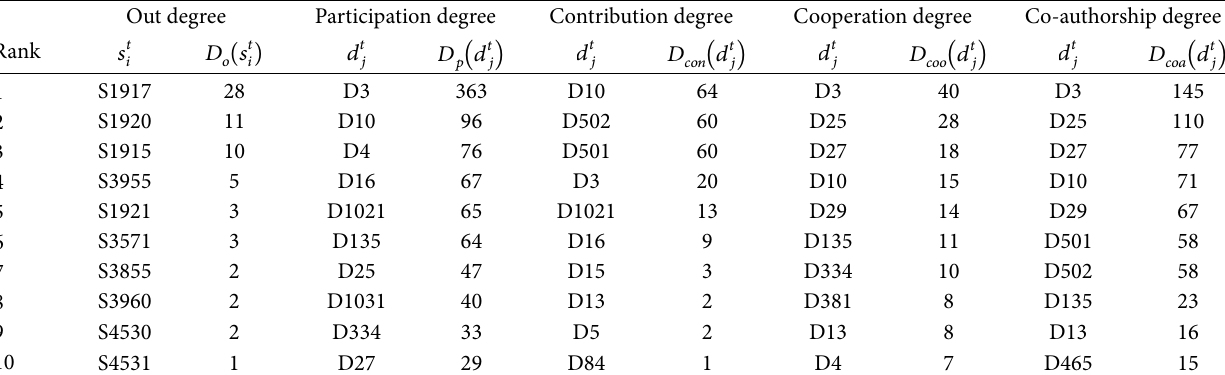
Table 2: The top ten standards and drafters in high indicators till